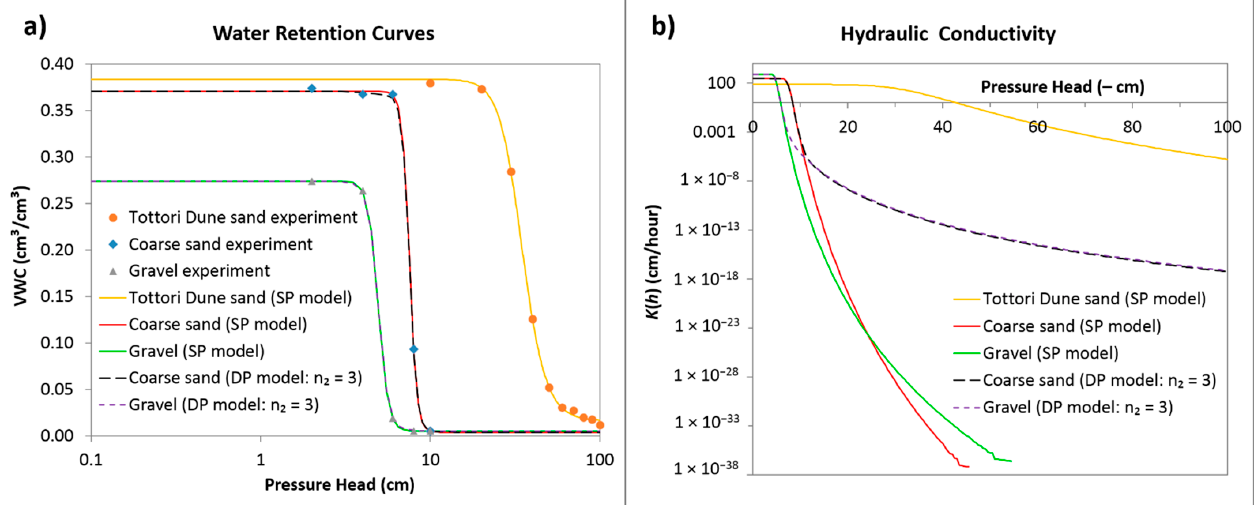
Figure 2. ( a ) Measured and fitted retention curves and ( b ) corresponding hydraulic conductivity functions of Tottori Dune sand, coarse sand, and gravel. The single (SP) and dual (DP) porosity models with n ₂ = 3 were used [12]. Table 1. Soil hydraulic parameters for the single-porosity (SP) and dual-porosity (DP) models for Tottori Dune sand, coarse sand, and gravel